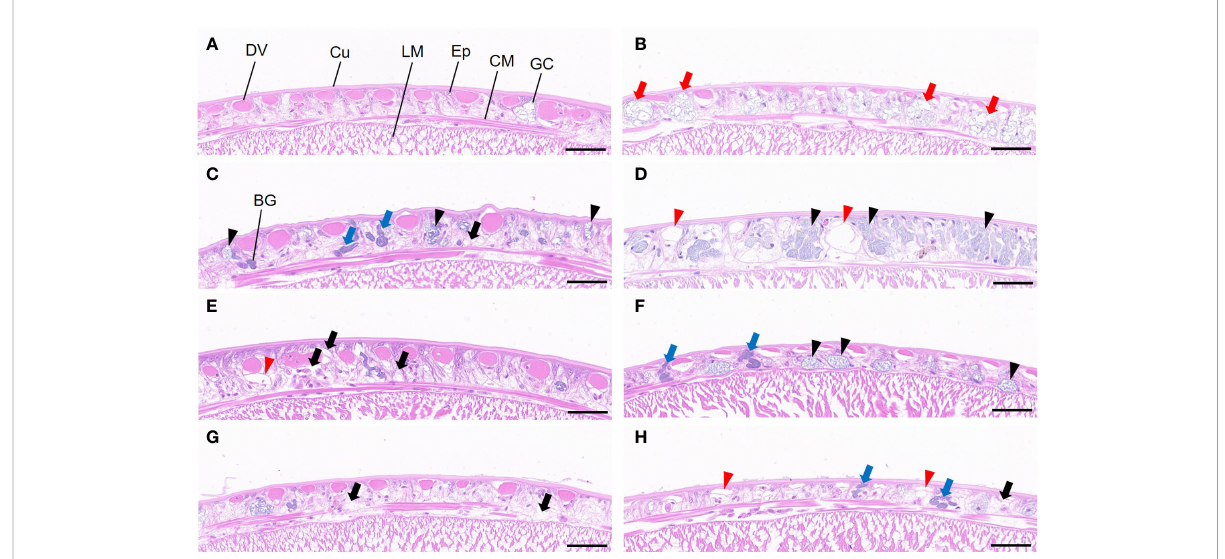
FIGURE 5 Histology (transverse section) of P. aibuhitensis dorsal body wall after 7 days of exposure to (A) Control, (B) 10 m g/L PS, (C) Cd L , (D) Cd L + PS, (E) Cd M , (F) Cd M + PS, (G) Cd H , and (H) Cd H + PS. Cu, cuticle; Ep, epithelial layer; DV, dorsal vessel; GC, gland cell; CM, circular muscle; LM, longitudinal muscle; BG, basophilic granule. The different symbols indicate cell swelling (red arrow), increase of basophilic granules (blue arrow), cytoplasmic loose (black arrow), cytosis of gland cells (black triangle), and cell vacuolation (red triangle). Scale bars are 50 m